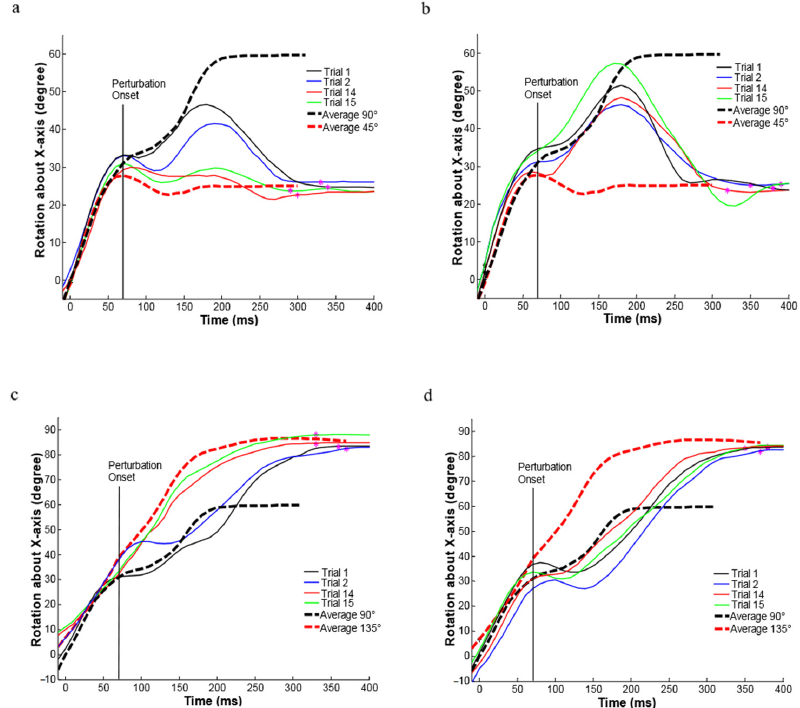
Figure 4. ( a ) Comparison of hand orientation trajectories under the repeat perturbation at 45 ◦ CCW (from 90 ◦ to 45 ◦ ). The four solid lines on each plot show four trials (the first two and the last two) for hand orientation trajectories recorded within one set. The two thick dashed lines were averaged from the unperturbed trials recorded in the same block. The magenta stars indicate target hit. ( b ) Comparison of hand orientation trajectories under the random perturbation conditions: perturbed at 45 ◦ CCW (from 90 ◦ to 45 ◦ ). ( c ) Comparison of hand orientation trajectories under the repeat perturbation conditions: perturbed at 45 ◦ CCW and perturbed at 45 ◦ CW (from 90 ◦ to 135 ◦ ). ( d ) Comparison of hand orientation trajectories under the random perturbation conditions: perturbed at 45 ◦ CCW and perturbed at 45 ◦ CW (from 90 ◦ to 135 ◦ ).